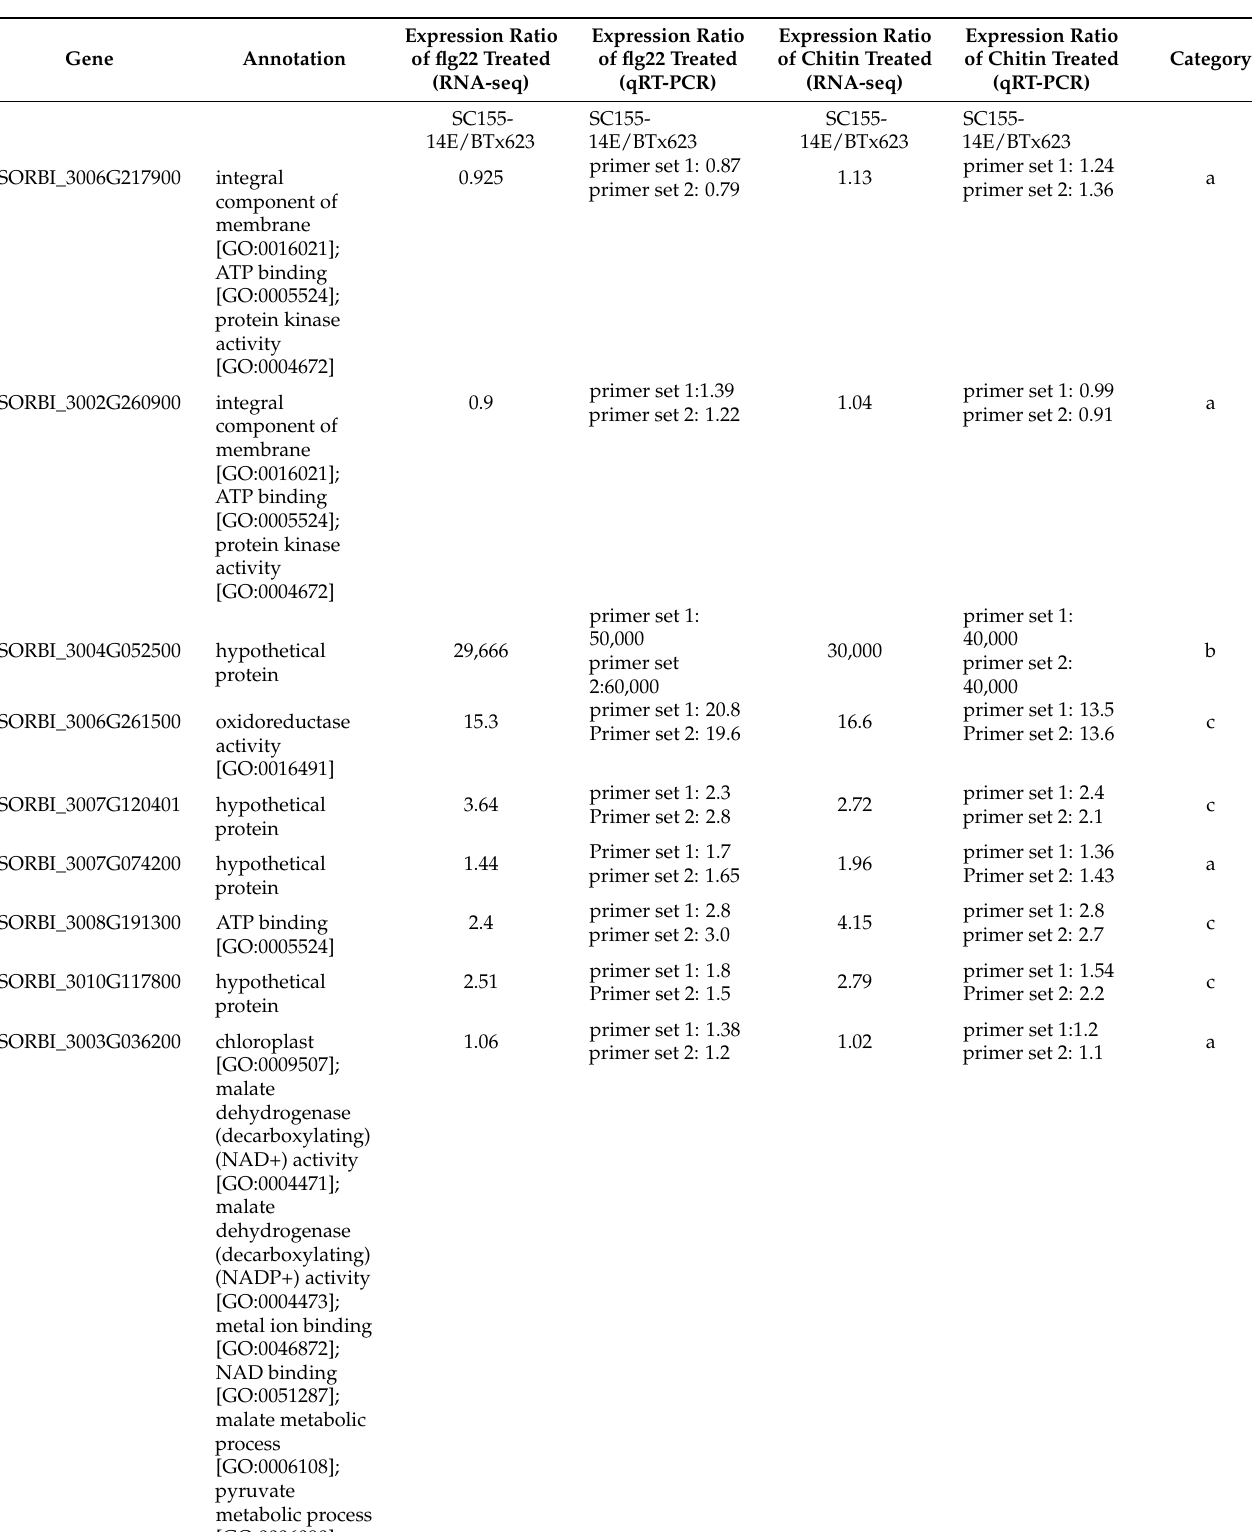
Table 1. Comparison of expression levels detected by RNA-seq and q-RT PCR of selected genes with flg22 or chitin